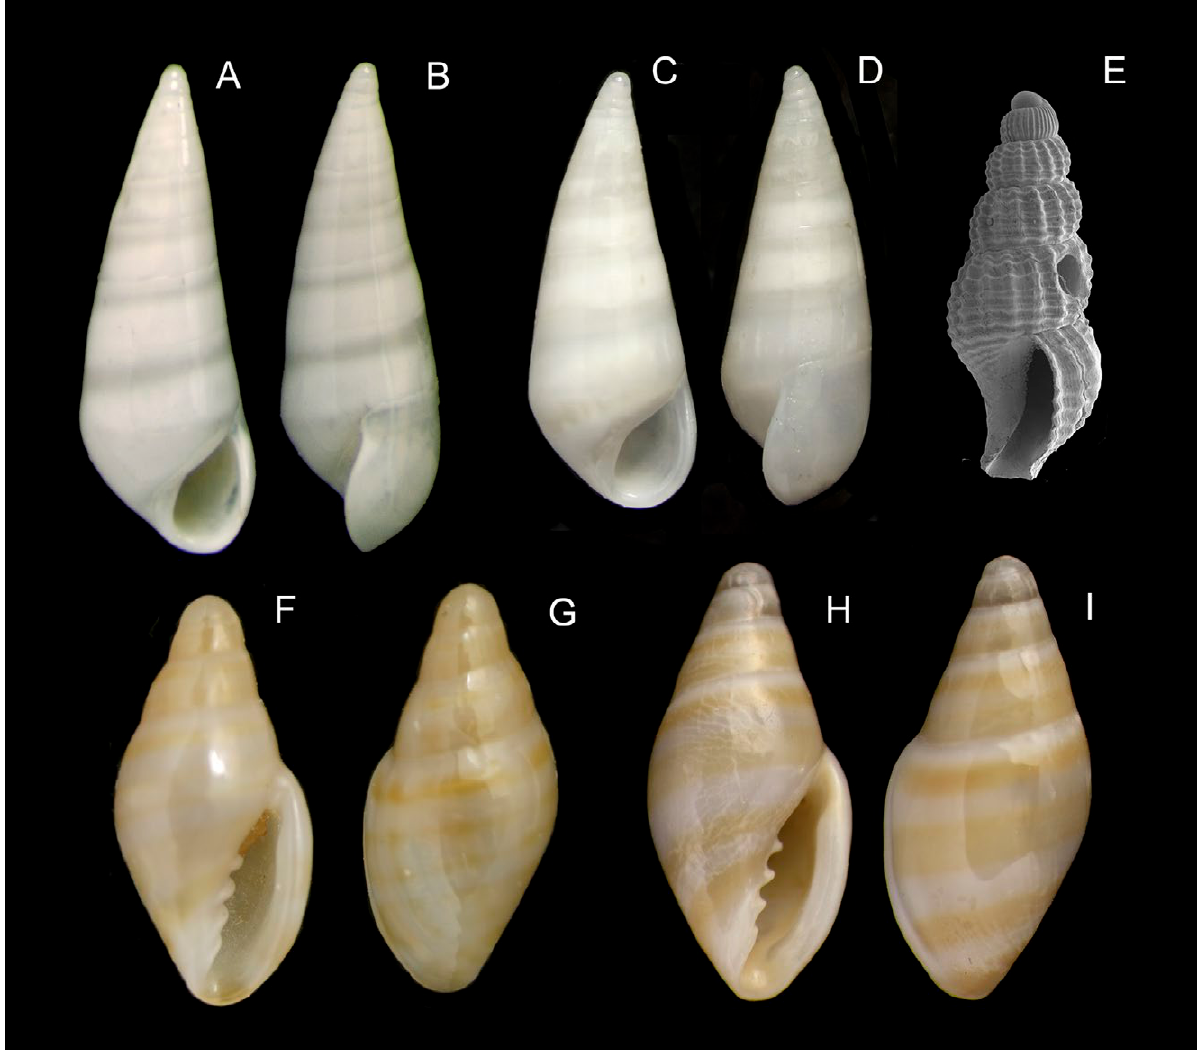
Fig. 4. – A-B, Melanella doederleini (Brusina, 1886), INDEMARES/CHICA 0610 DA6, 478 m depth (3.7 mm); C-D, M. doederleini , IN- DEMARES/CHICA 0610 BC9.2, 457 m (3.3 mm); E, Chauvetia balgimae Gofas and J. D. Oliver, 2010, INDEMARES/CHICA 0610 DA5, 422 m (5.3 mm); F-G, Dentimargo auratus Espinosa, Ortea and Moro, 2014, INDEMARES/CHICA 0610 DA11, 461 m (5.7 mm); H-I, D. auratus , “Vanneau” 1923-1929, sampling station 10, 110 m (6.7 mm). DA, benthic dredge; BC,